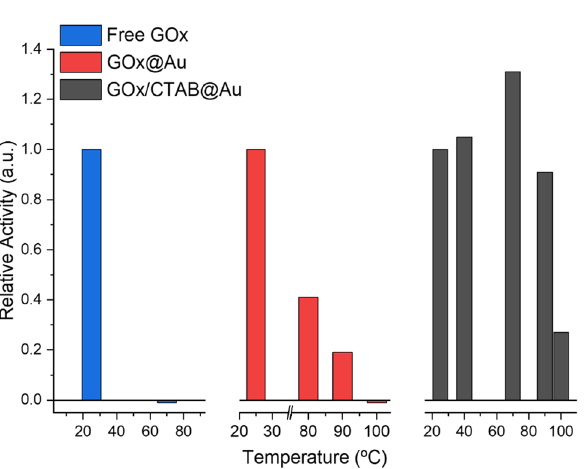
Figure 3. The jump in thermal stability of GOx upon its co-entrapment with CTAB within gold. Left: GOx in solution. Middle: GOx@Au. Right: